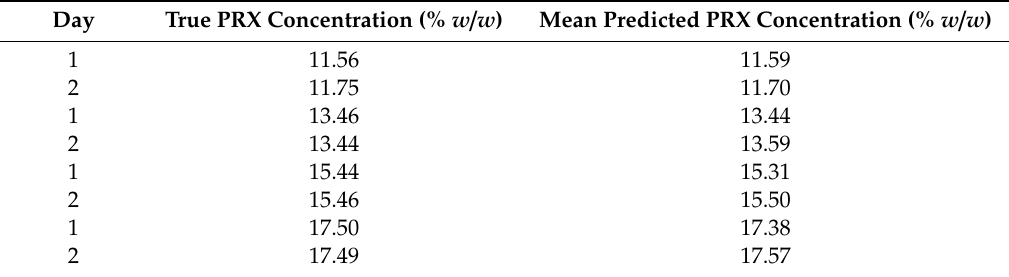
Table 3. Predicted PRX content in each validation